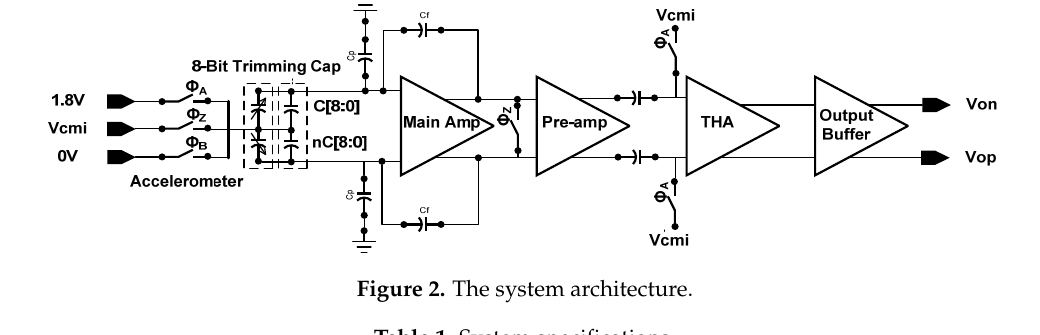
Figure 2. The system architecture. Table 1. System specifications.